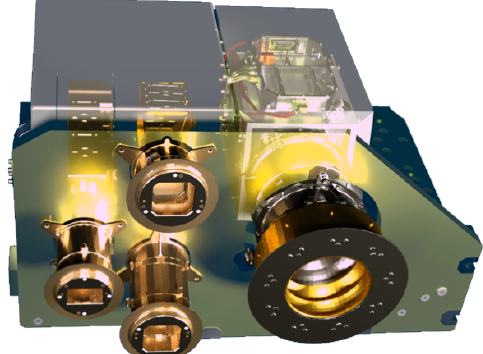
Figure 1. The SIMBIO-SYS suite package